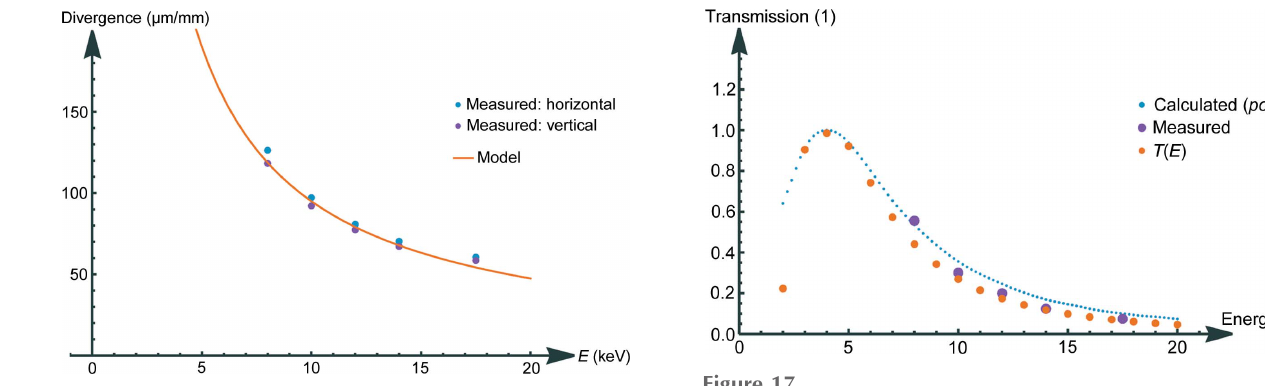
Figure 15 Energy dependence of the divergence far from the focal distance.